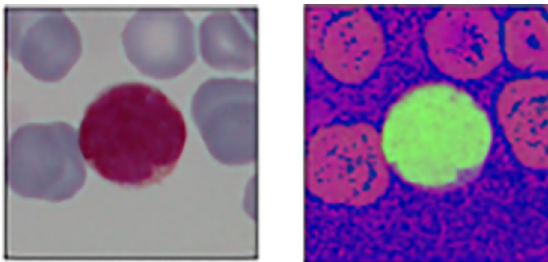
Figure 2. BGR and HSV format input images.